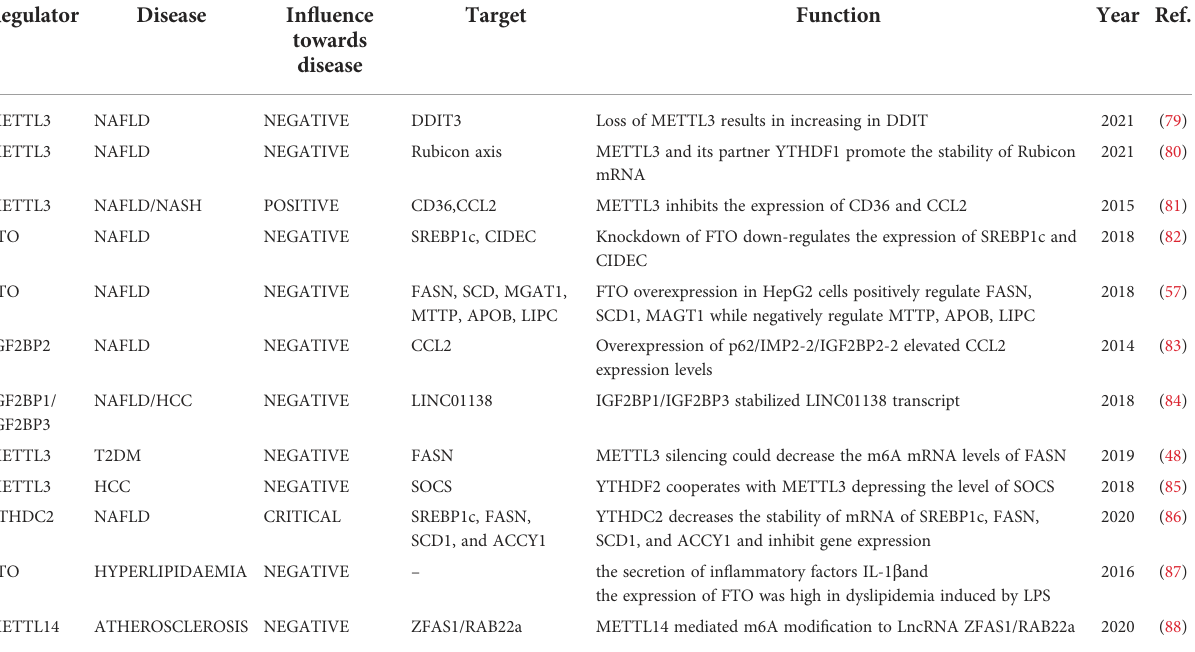
TABLE 1 Multiple functions of RNA m6A methylation regulator in lipid metabolic disease. Regulator Disease In fl uence Target Function Year towards disease